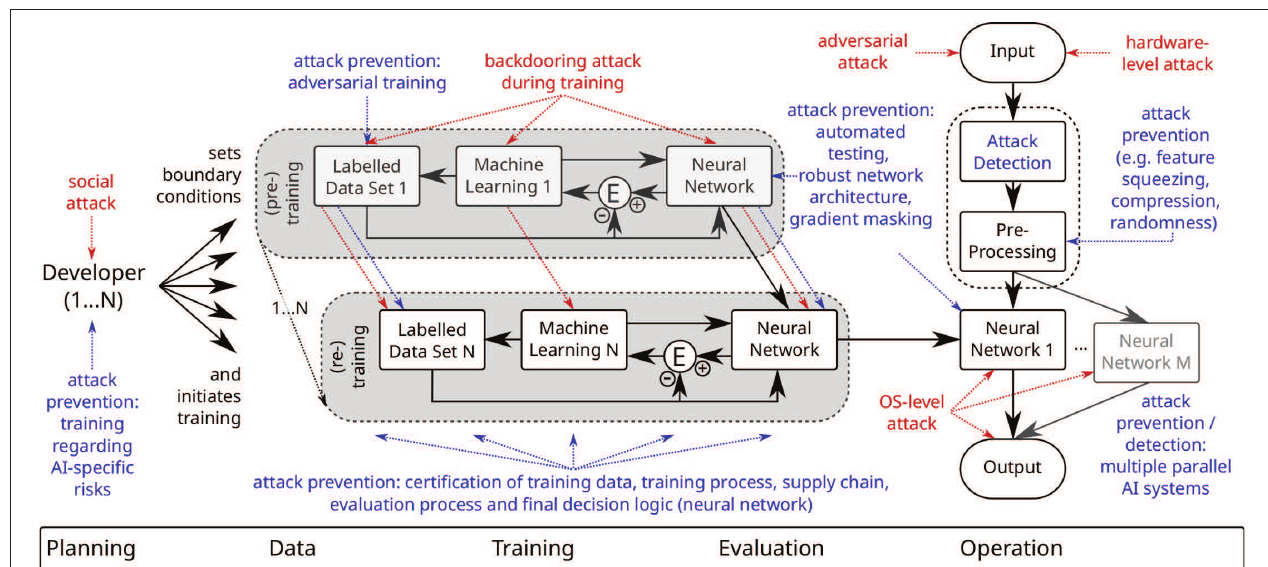
FIGURE 7 | Summary of possible attacks (red) on AI systems and defenses (blue) specific to AI systems depicted along the AI life cycle. Defenses not specific to AI systems, e.g., background checks of developers, hardware access control etc. are not shown here and should be adopted from classical IT security. Multiple AI training sessions with different data sets indicate the risk associated with pre-trained networks and externally acquired